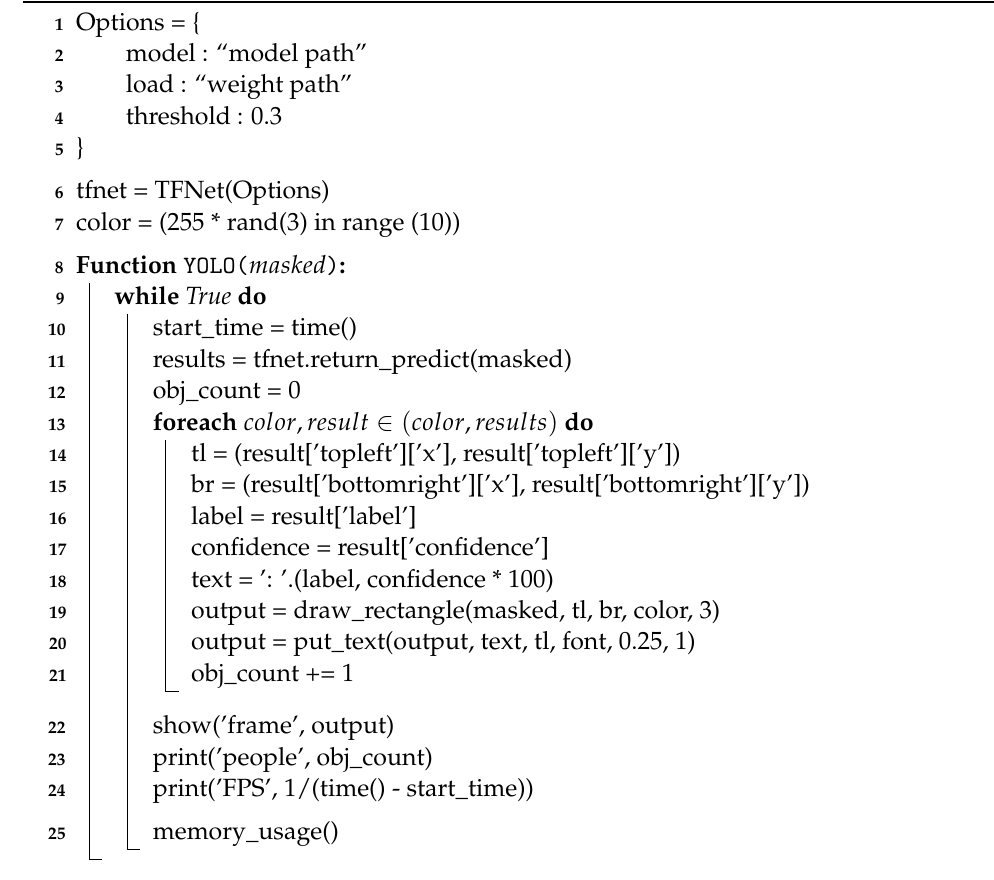
Algorithm 2: Pseudo-code for YOLO object